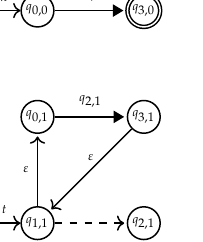
. a ∗ (cid:104) (cid:105)